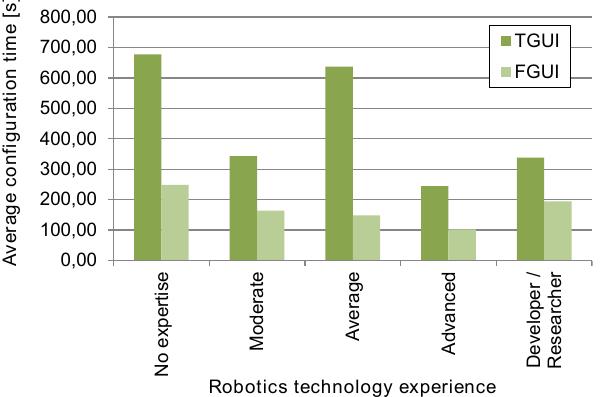
Figure 9: Correlation between experience in robotics and total time spent using the user interface